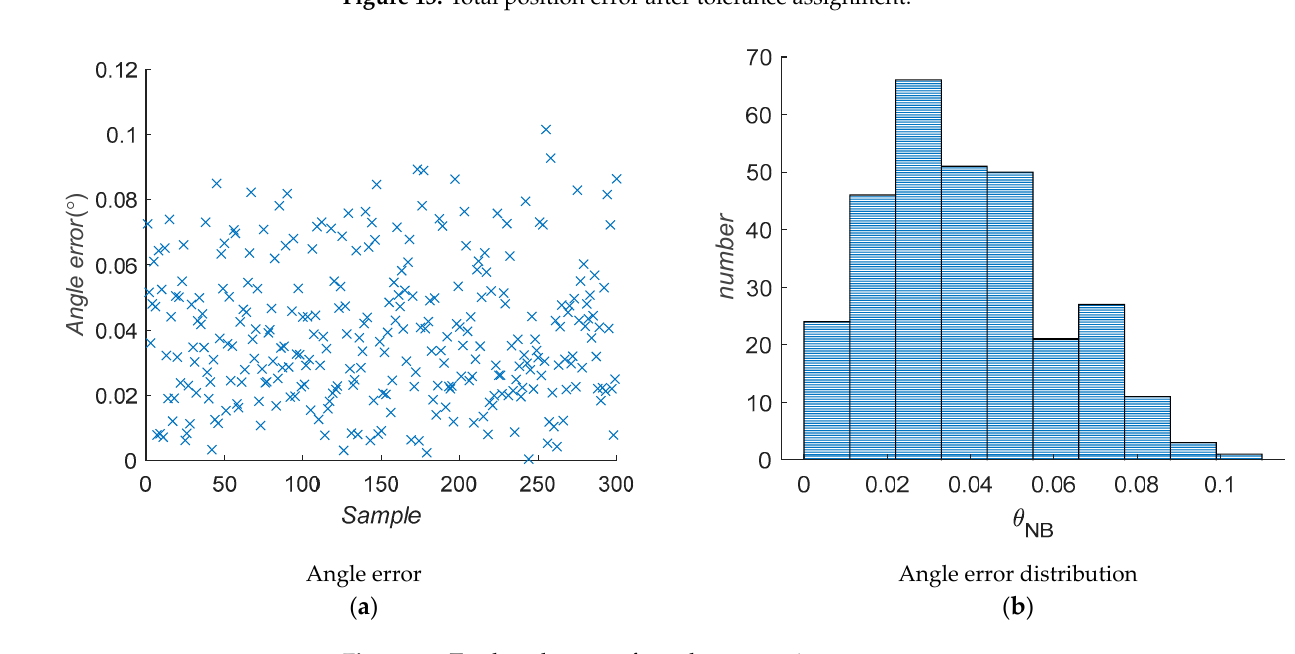
Figure 13. Total position error after tolerance assignment.